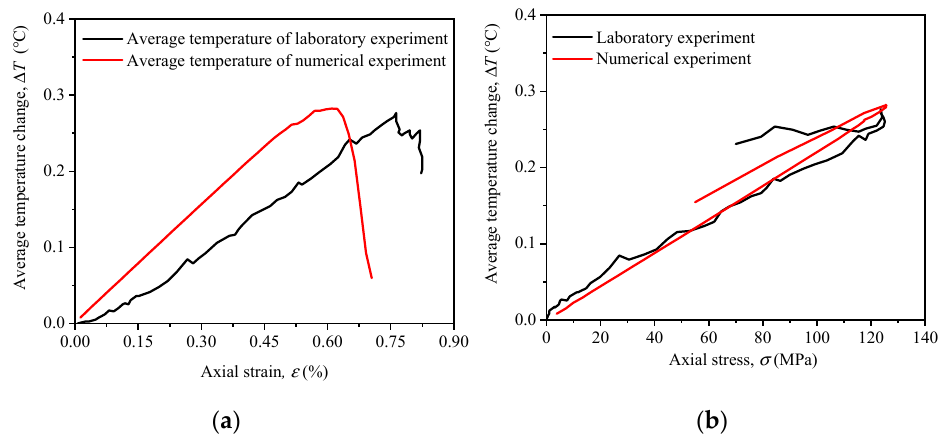
Figure 5. Changes in average temperature Δ T ave are associated with increasing axial strain ( a ) and axial stress ( b ) in the laboratory experiment and the numerical experiment.